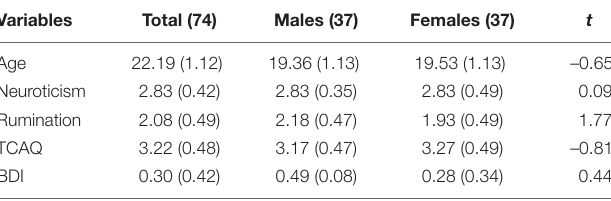
TABLE 1 | Descriptive statistics in Study 1 ( M, SD ).